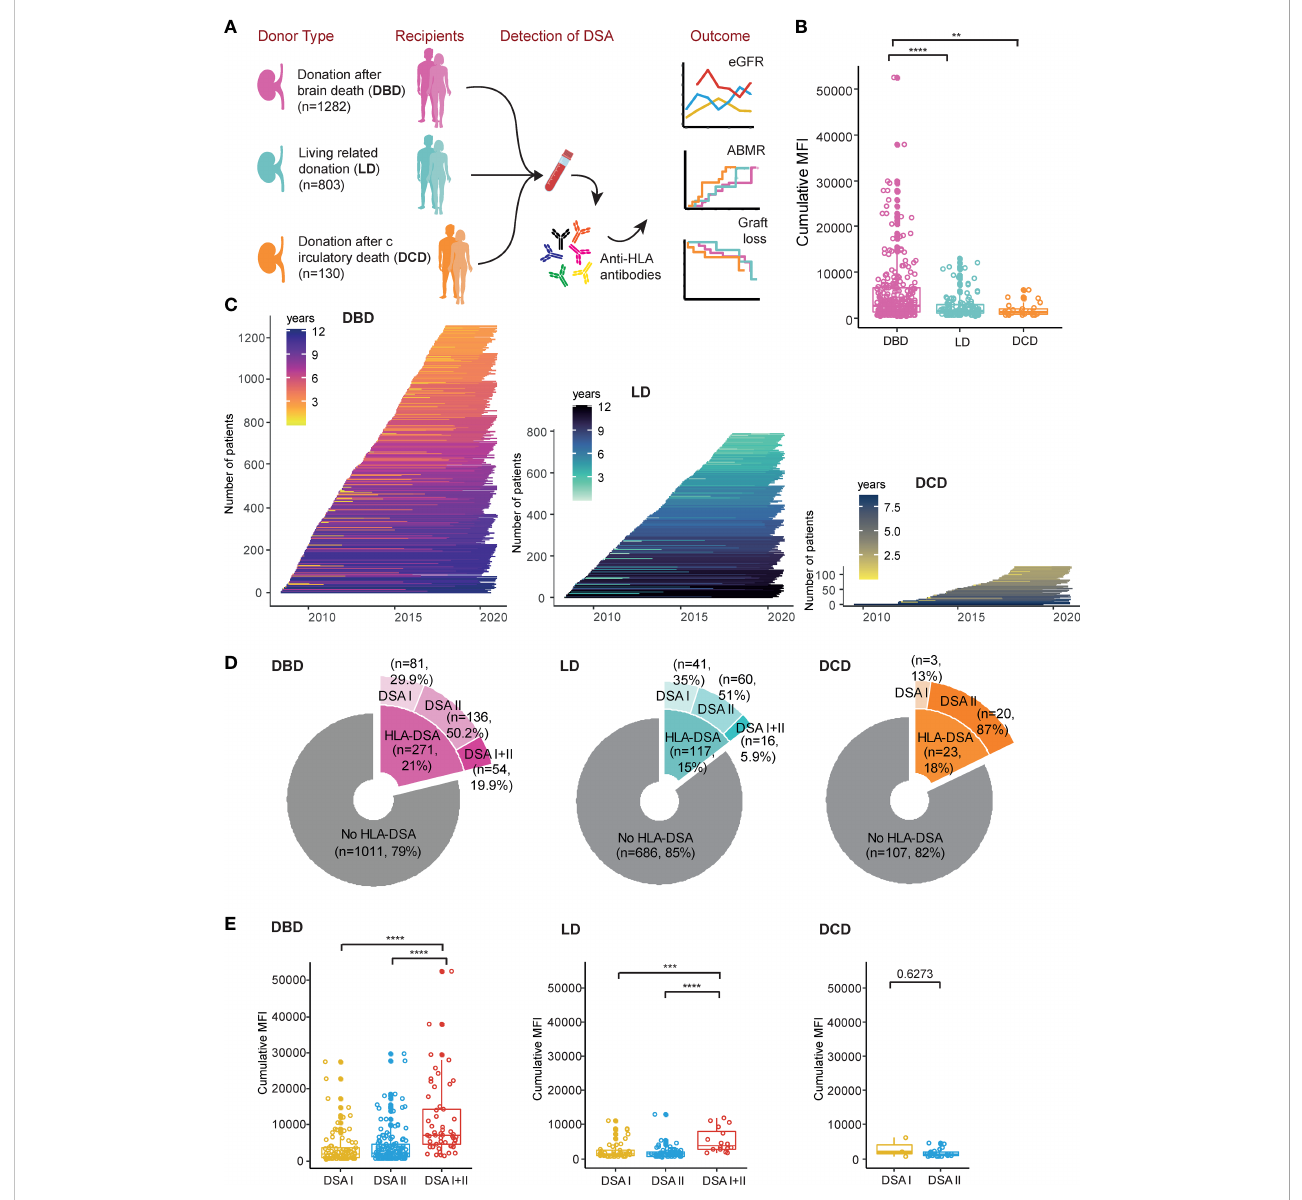
FIGURE 1 Overview of the STCT cohort and the grouping of patients based on donation type. (A) Flowchart indicating the number of patients for the different donation types (DBD, LD and DCD), detection of DSA and the major analyses performed in this study. (B) The distribution of the cumulative MFI value of DSA positive patients. (C) Follow-up time in each individual patient. (D) Details of the patients in the “ no HLA-DSA ” group and different DSA sub-groups. (E) The summary of the cumulative MFI value of different DSA classes in the different donation types. **p<0.01, ***p<0.001,